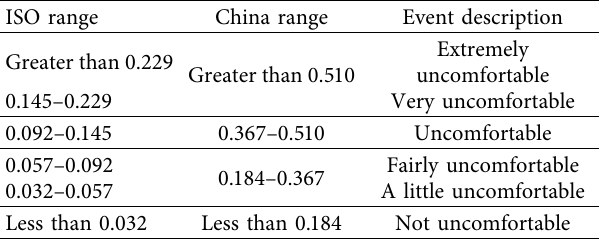
Table 7: Passengers’ comfort